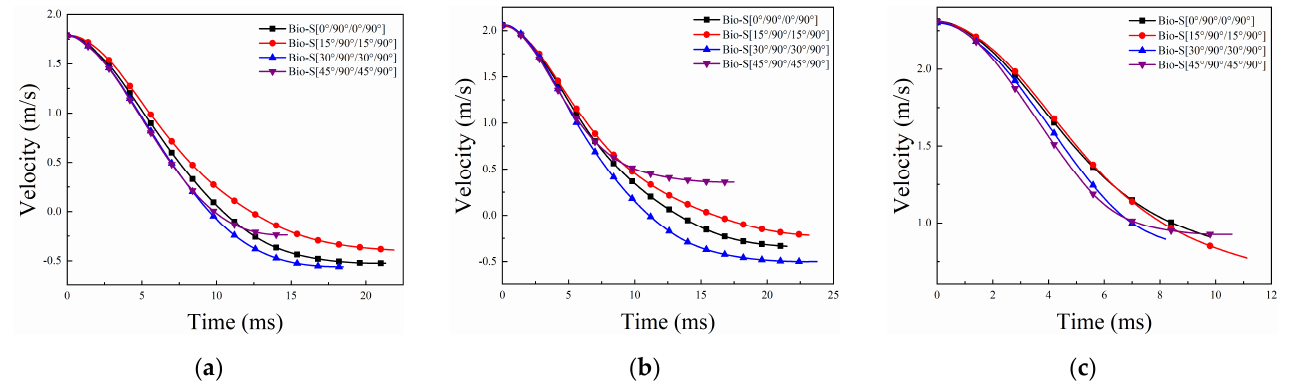
Figure 13. Velocity-time curves of the Bio-S composite plates with different angles of first-third layers configurations under different impact energy levels: ( a ) 15 J; ( b ) 20 J; ( c ) 25 J.